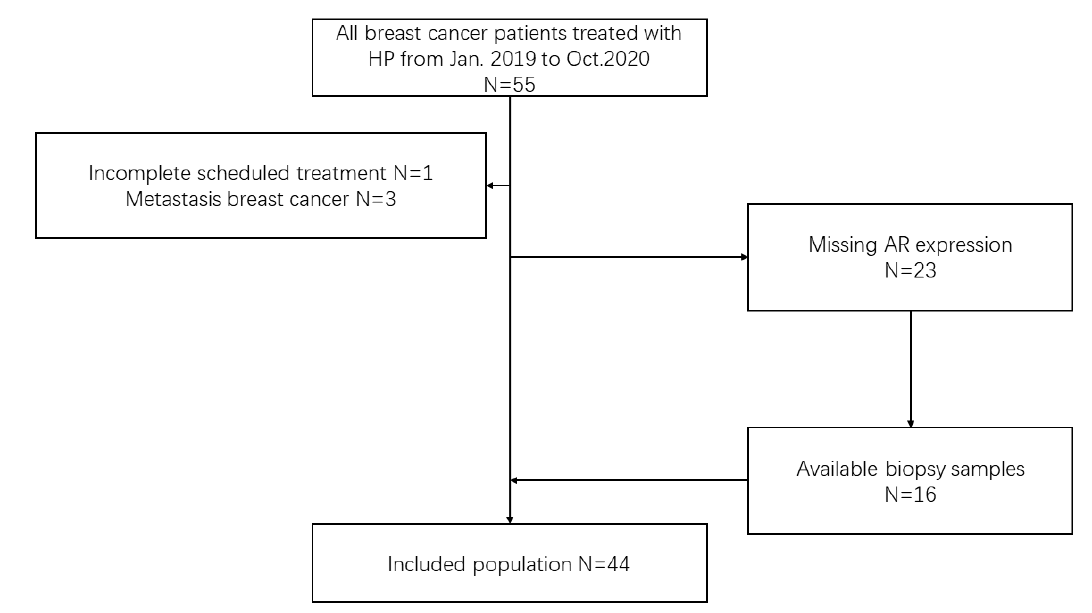
Figure 1. Flow diagram of the patient population. HP neoadjuvant therapy containing trastuzumab and pertuzumab, AR androgen receptor.